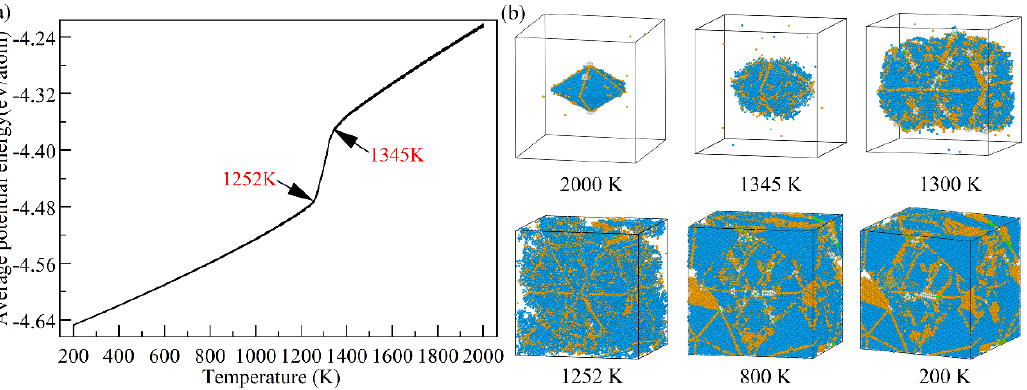
Figure 2. ( a ) Average atomic energy and ( b ) snapshots of several temperature points. Atoms detected as others by OVITO were removed. FCC structures are colored blue, and HCP structures are colored orange.